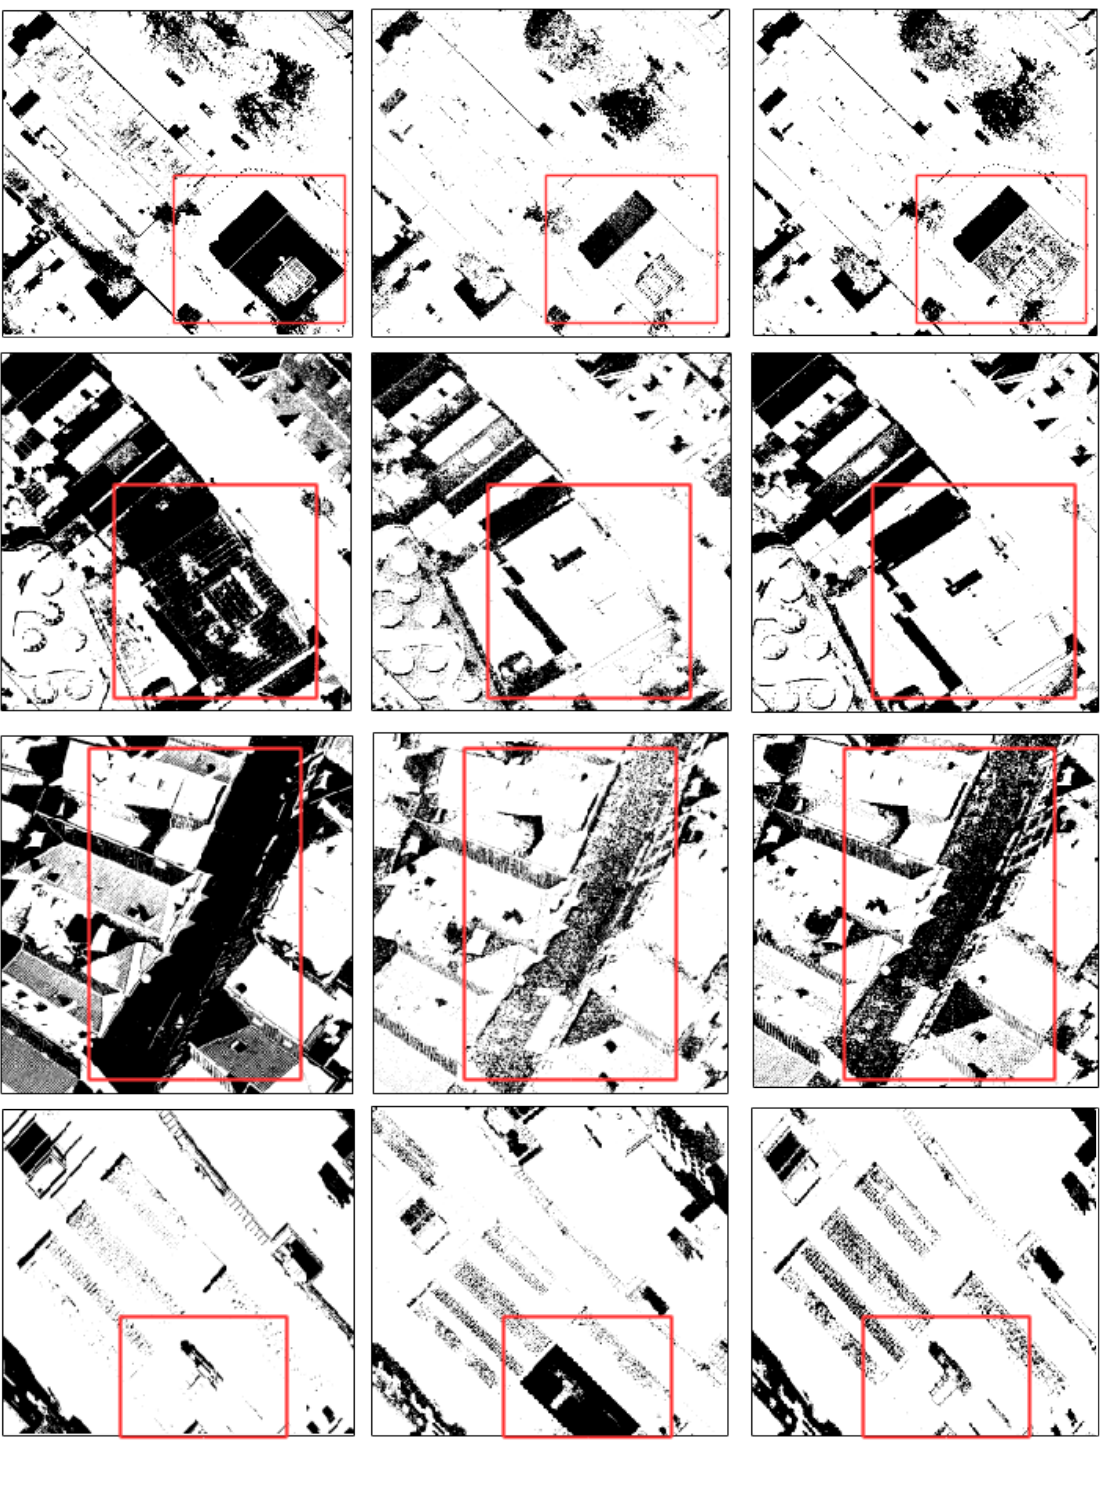
Figure 6. The shadow detection images for the four cases listed in Figure4 from Amersfoort with different approaches. The left, middle and right column of images are obtained from QDA on RGB domain, QDA on ratio domain and decision fusion